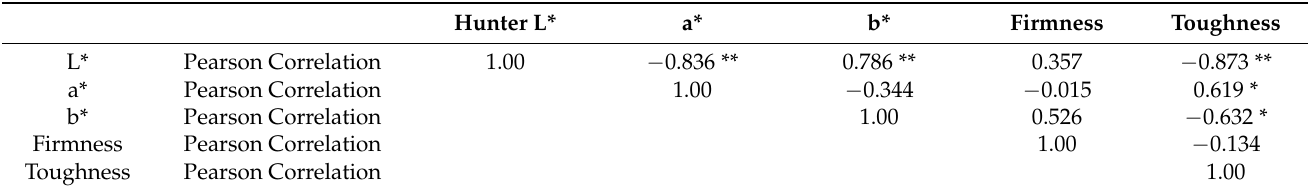
Table 4. The correlation between color and texture of the whole grains of white maize, yellow PVABM, red and brown BGN varieties.